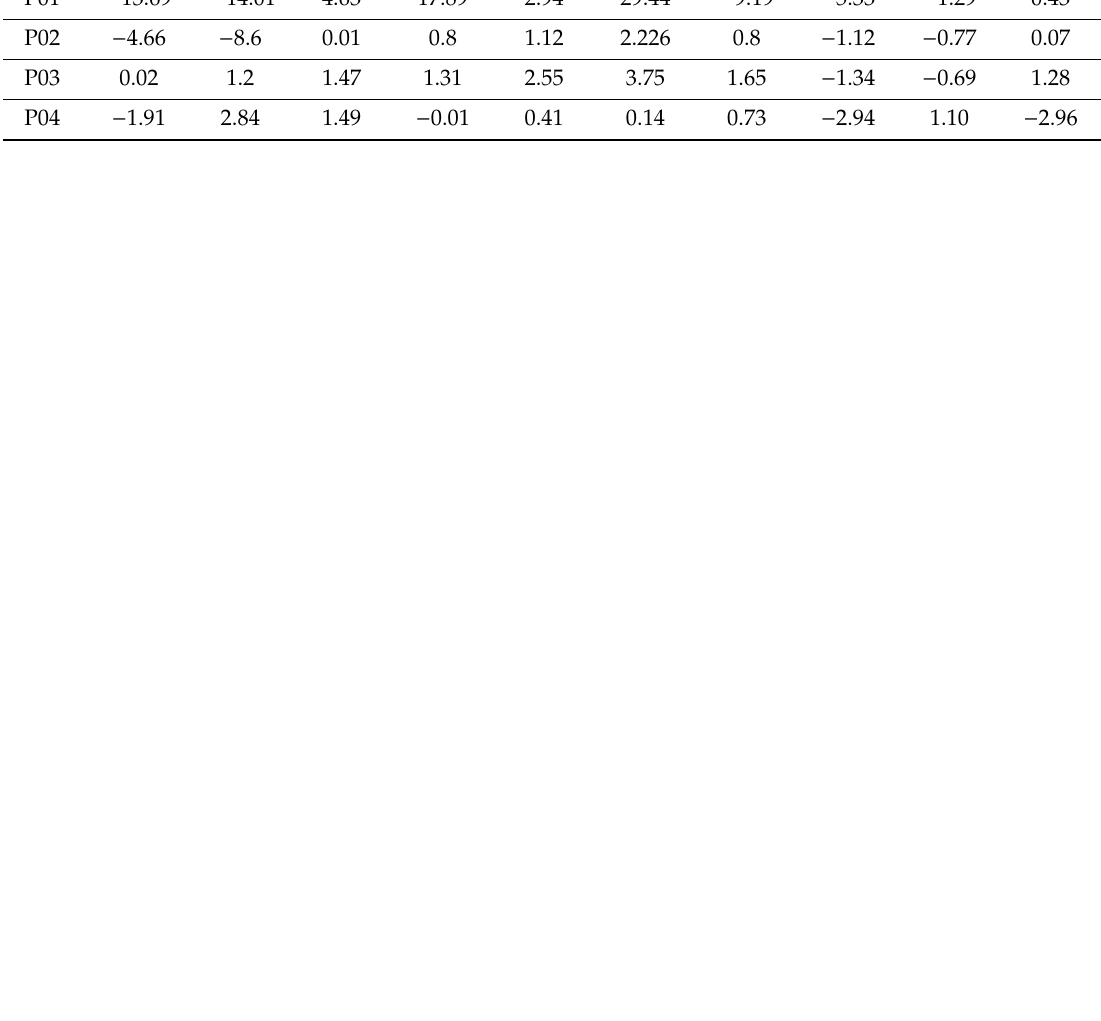
Table 5. Average coastline accretion / erosion in meters / month between shorelines control points in normal periods and EN events. The highest values for each period are highlighted in bold.